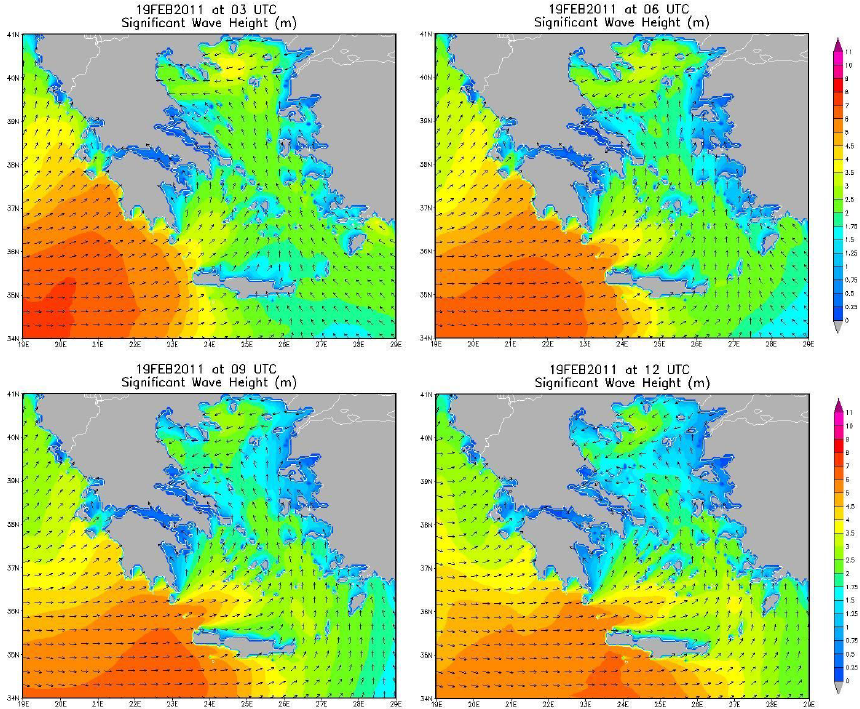
Fig. 5. Evolution of the wave height and direction produced by the first 24h forecast of the WAM model. The fields refer to (a) 03:00, (b) 06:00, (c) 09:00 and (d) 12:00UTC, 19 February. The red colours in the southern part of the region denote significant wave heights higher than 4.5m. The arrows represent the mean direction of the waves.